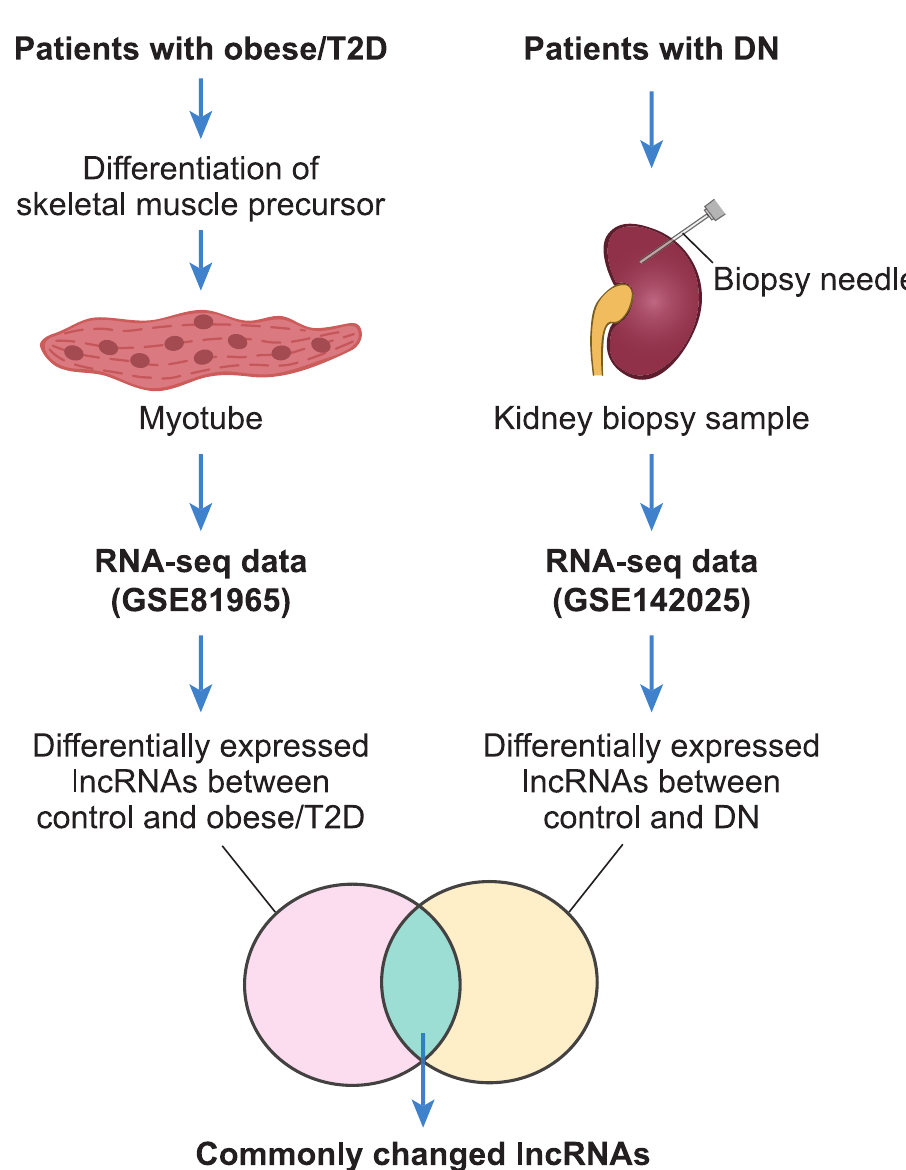
Fig 1. Analysis procedure to measure long non-coding RNAs (lncRNA) expression in the myotubes and kidney tissues of patients with diabetes. See the main text for details.